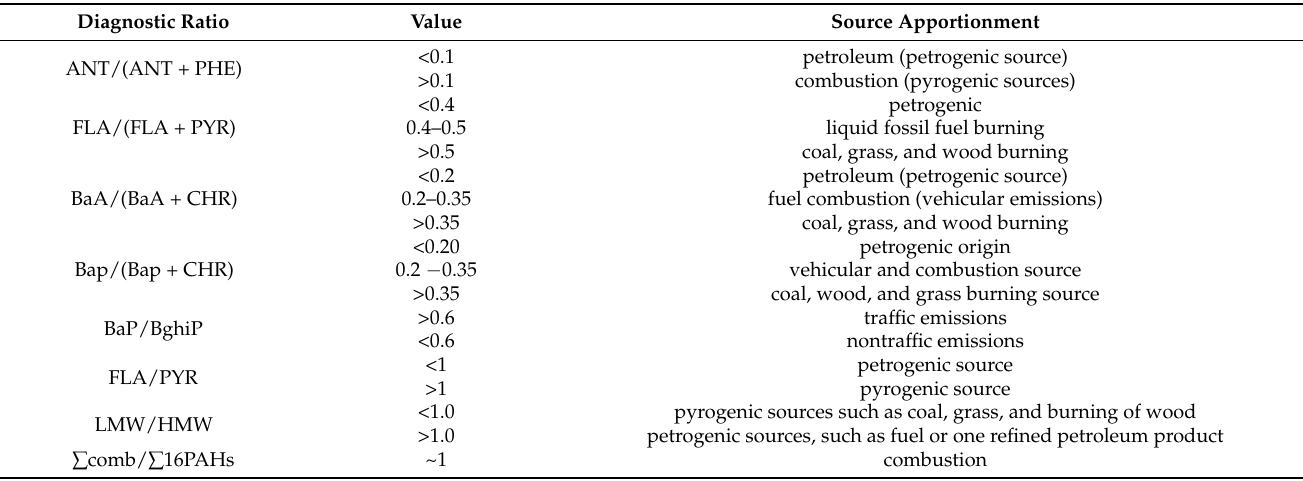
Table 2. Guidelines for PAH diagnostic ratios considered for identifying sources of PAHs in vegetables and soil